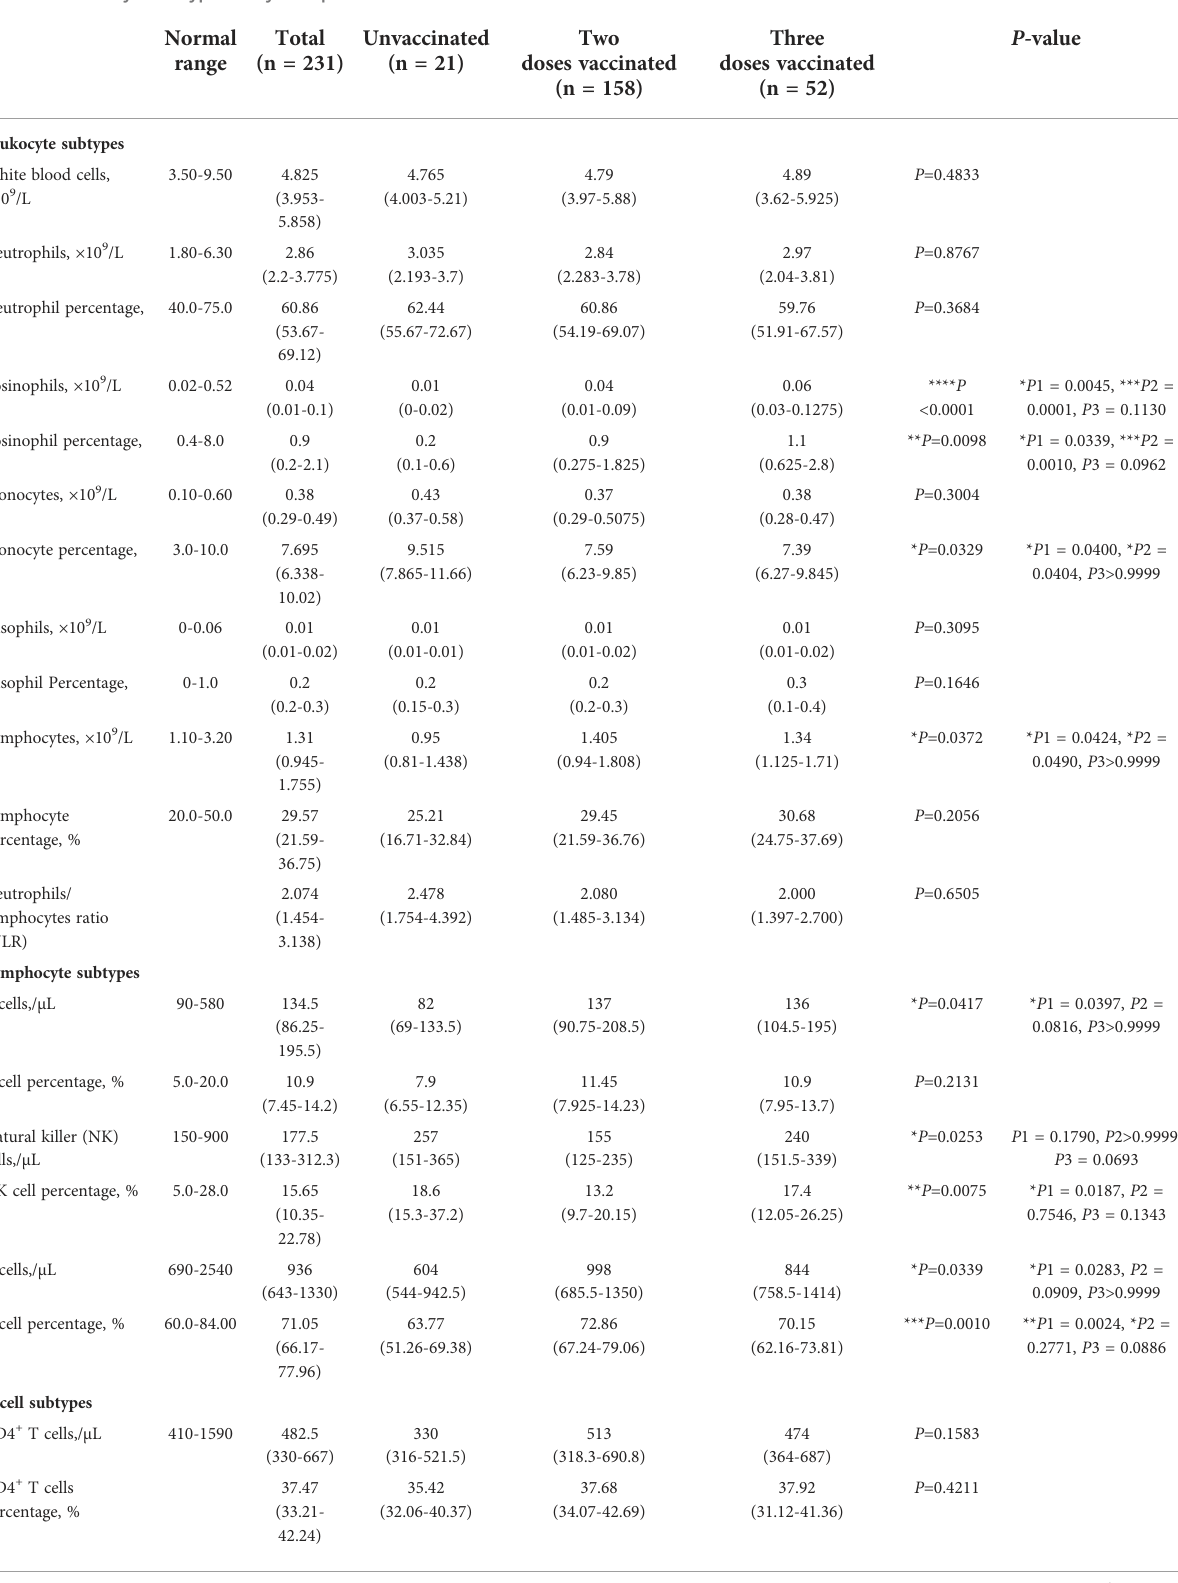
TABLE 3 Leukocyte subtypes analysis in patients with COVID-19. Normal